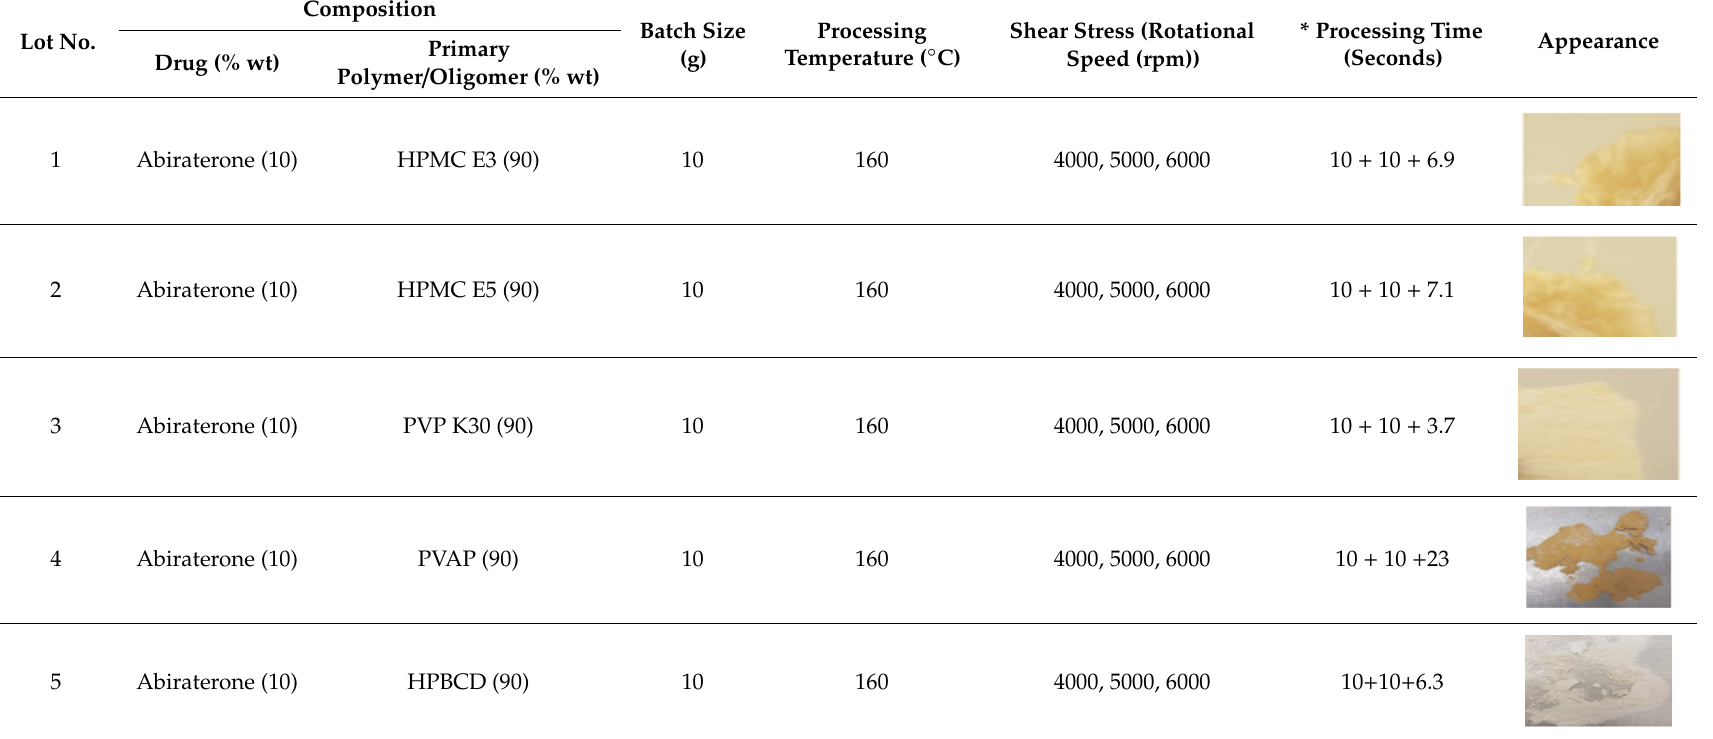
Table 2. Binary KSD compositions, processing parameters, and their corresponding appearance.